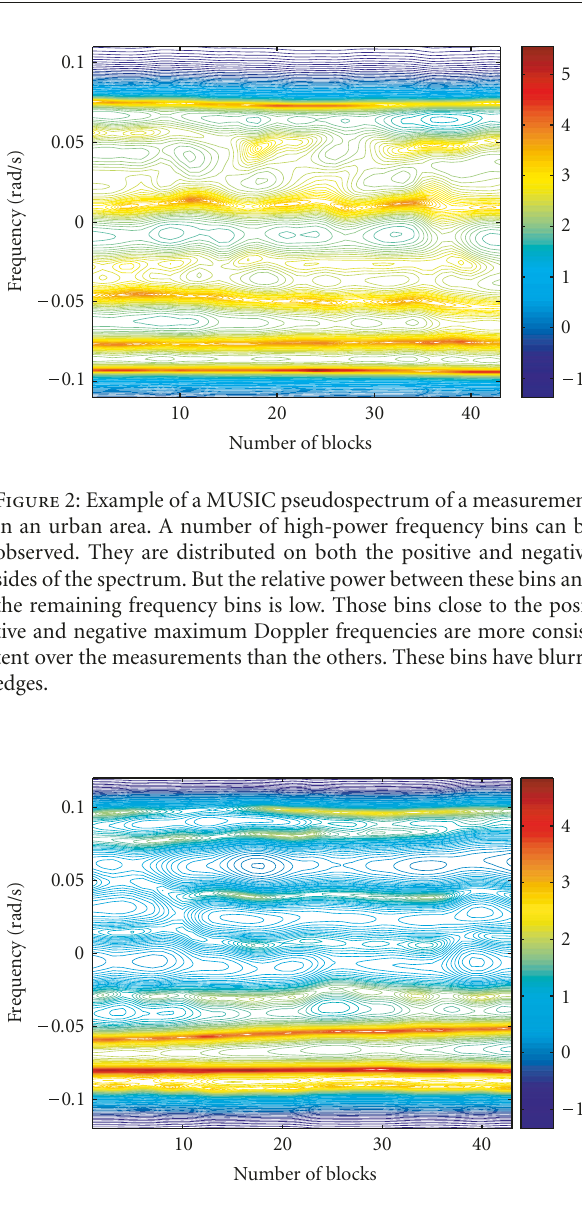
Figure 3: Example of a MUSIC pseudospectrum of a measurement in a suburban area. A fewer number of high-power frequency bins are observed compared to Figure 2. The locations of these frequency bins are biased to the negative side in the spectrum. The edges of these high-power frequency bins are much sharper than those in Figure 2. The power in the strongest frequency bin is much higher than the others and is consistent over the whole measurement in-